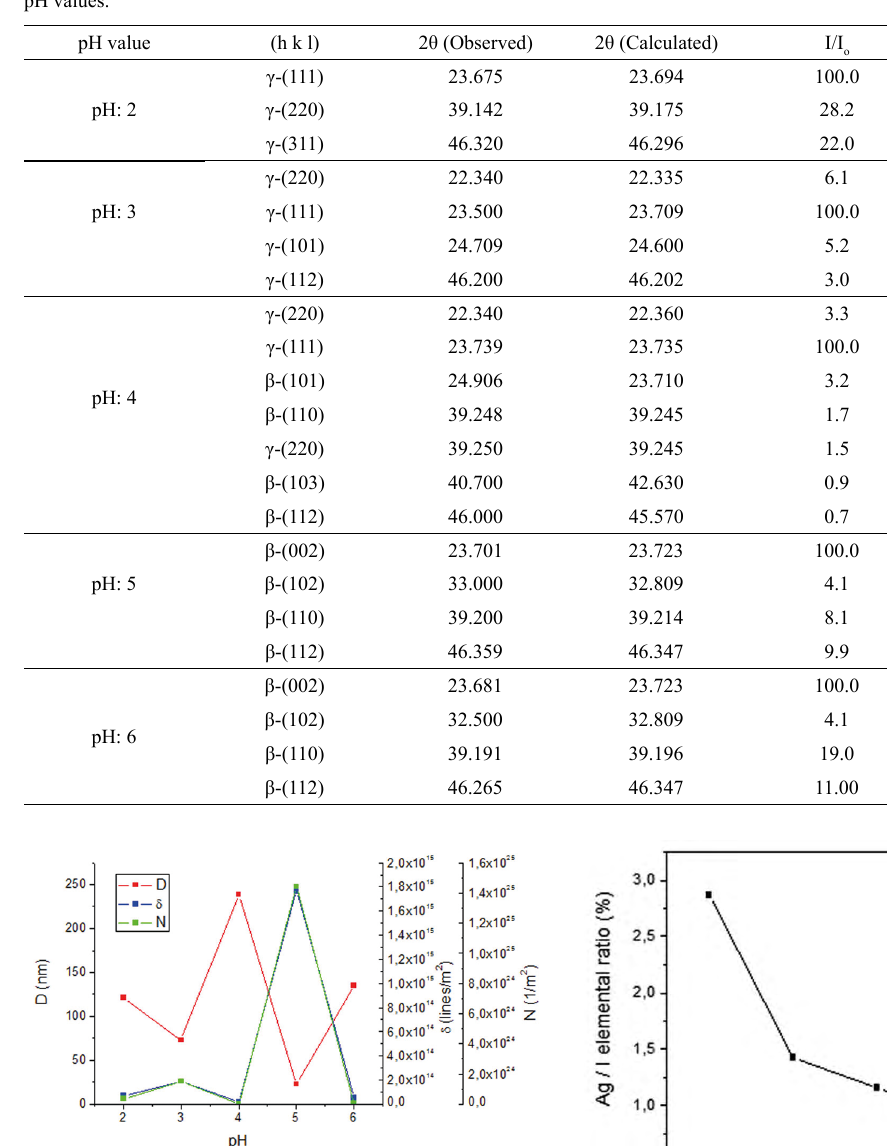
Figure 2. Variation of the dislocation density (δ), the number of crystalline (N) and the crystallite size (D) of the AgI thin films as a function of the pH of the chemical bath.